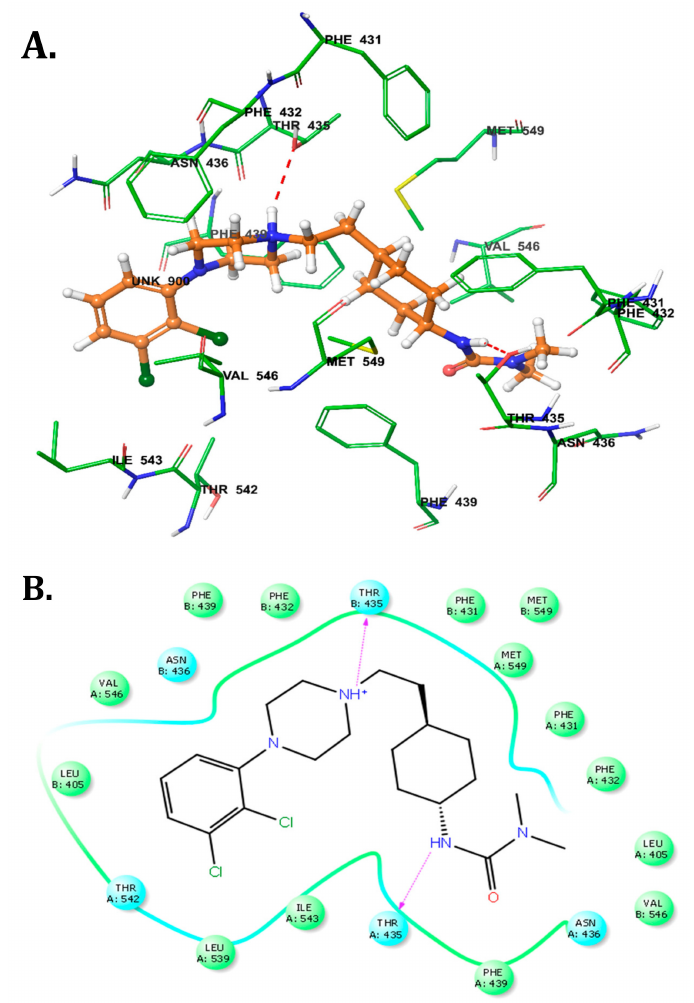
Figure 7. Model for the binding of cariprazine with ABCG2 transporter. ( A ) XP-Glide predicted binding mode of cariprazine in drug binding cavity of human ABCG2 transporter (PDB ID: 6ETI). Important amino acids are depicted as sticks with the atoms colored as carbon = green, hydrogen = white, nitrogen = blue, oxygen = red. The ligand cariprazine is shown with the same color scheme as above except for the carbon atoms, represented in orange and the chlorine atoms represented in dark green. The red dotted lines represent hydrogen bond. ( B ) A schematic diagram of the protein–ligand interaction is shown for cariprazine. Blue circles depict polar amino acids and green circles depict hydrophobic amino acids. The purple arrows depict side chain donor/acceptor